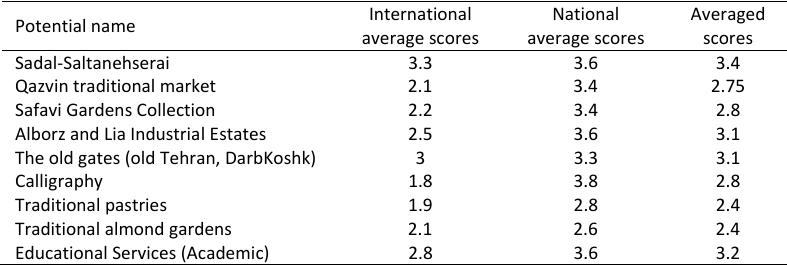
Table 1: The selected potential for branding plan of Qazvin urban agglomeration